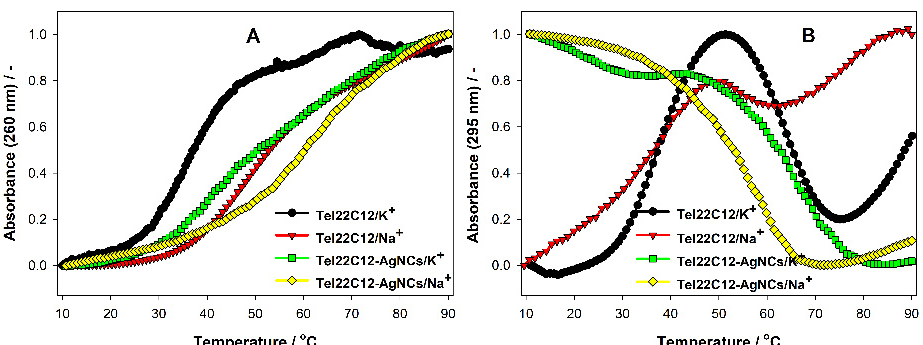
Figure 4. Normalized UV melting profiles of Tel22C12 and Tel22C12-AgNCs (2 µ M) in 10 mM Tris- acetate buffer (pH = 7.5) containing 100 mM NaCl or 100 mM KCl; monitored at 260 nm ( A ) or 295 nm ( B